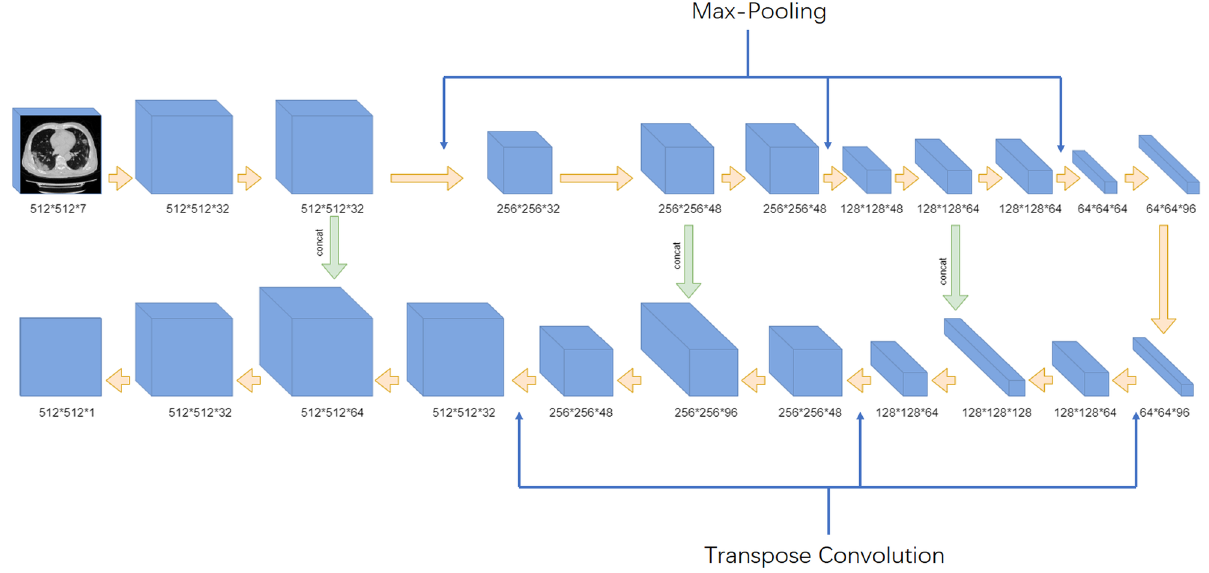
Figure 1. COVID-Lesion Net structure for pneumonia detection and